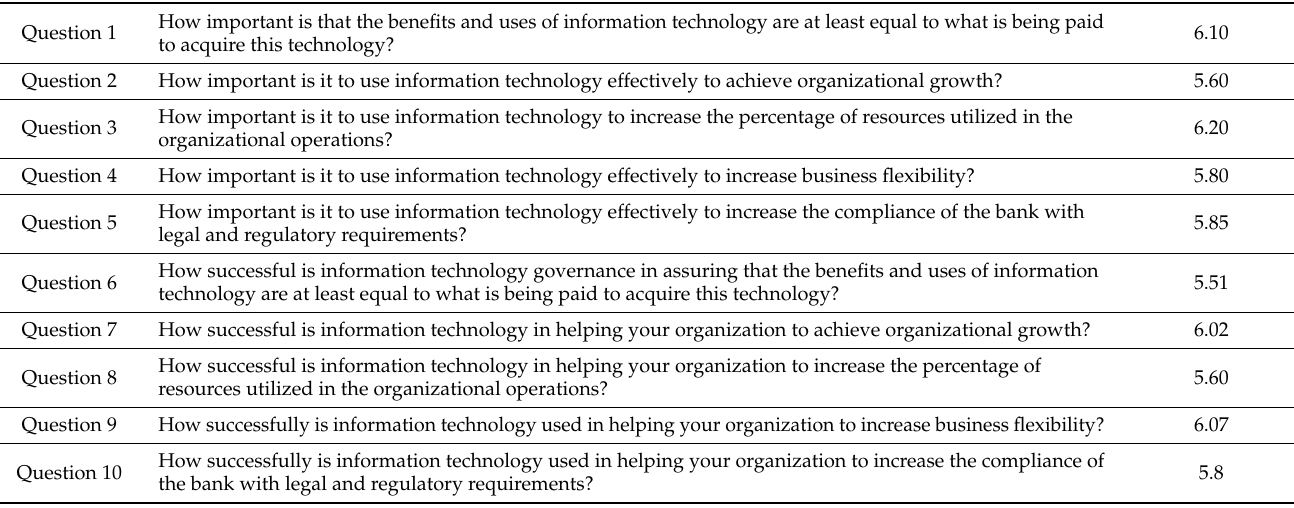
Table 3. Importance and success of ITG in the respondents’ banks a .